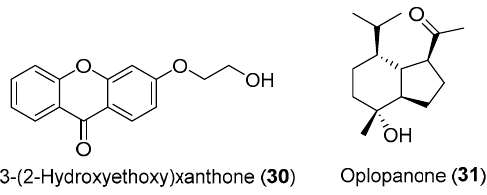
Figure 2. Chemical structure of the compounds 30 and 31 .